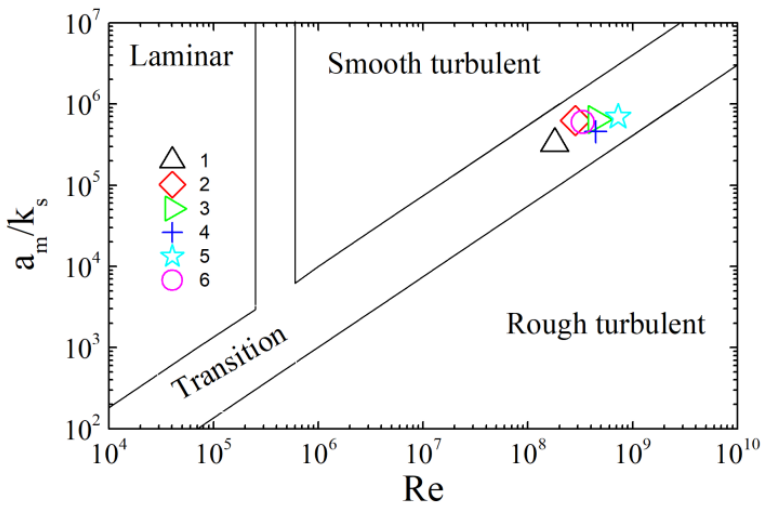
Figure 8. Flow regime of the 2011 tsunami. 3.2.4. Inspection of the Transitional Characteristics of the Boundary Layer Thickness and Friction Factor Using the full range equation of [24], the dimensionless boundary layer thickness ( δ /h ) and wave friction factor can be estimated and are illustrated in Figures 9 and 10, respectively. It is again confirmed that all six cases are located in the turbulent transitional region from a smooth turbulent flow to a rough turbulent flow. Therefore, the judgment of the flow regime is important in the boundary layer under a tsunami. In addition, under the actual tsunamis, the friction coefficient of a transition region has a small value compared with the friction coefficient of a rough turbulent flow.